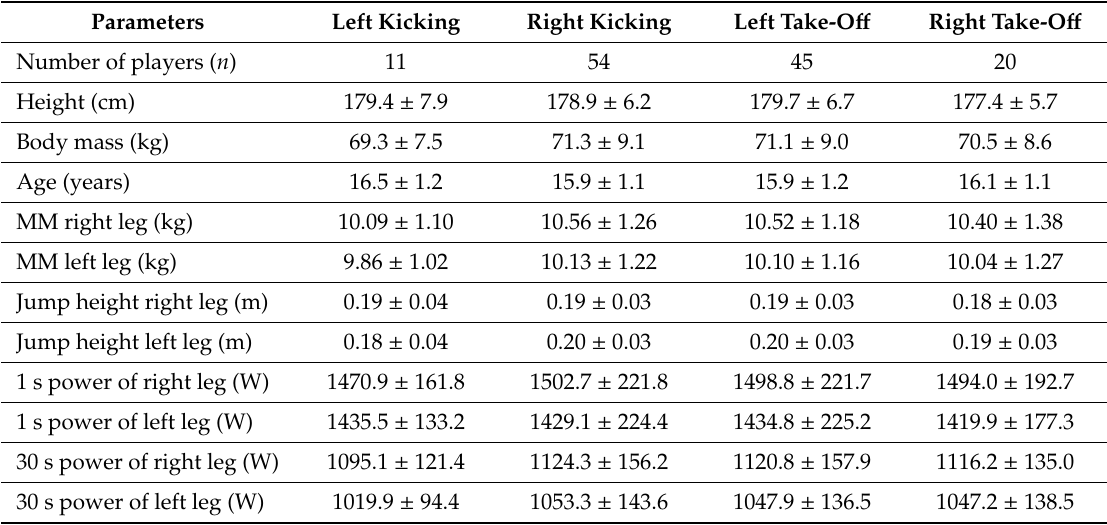
Table 1. Measured values of the monitored participants by lower limb preference for kicking and by lower limb preference for take-off.